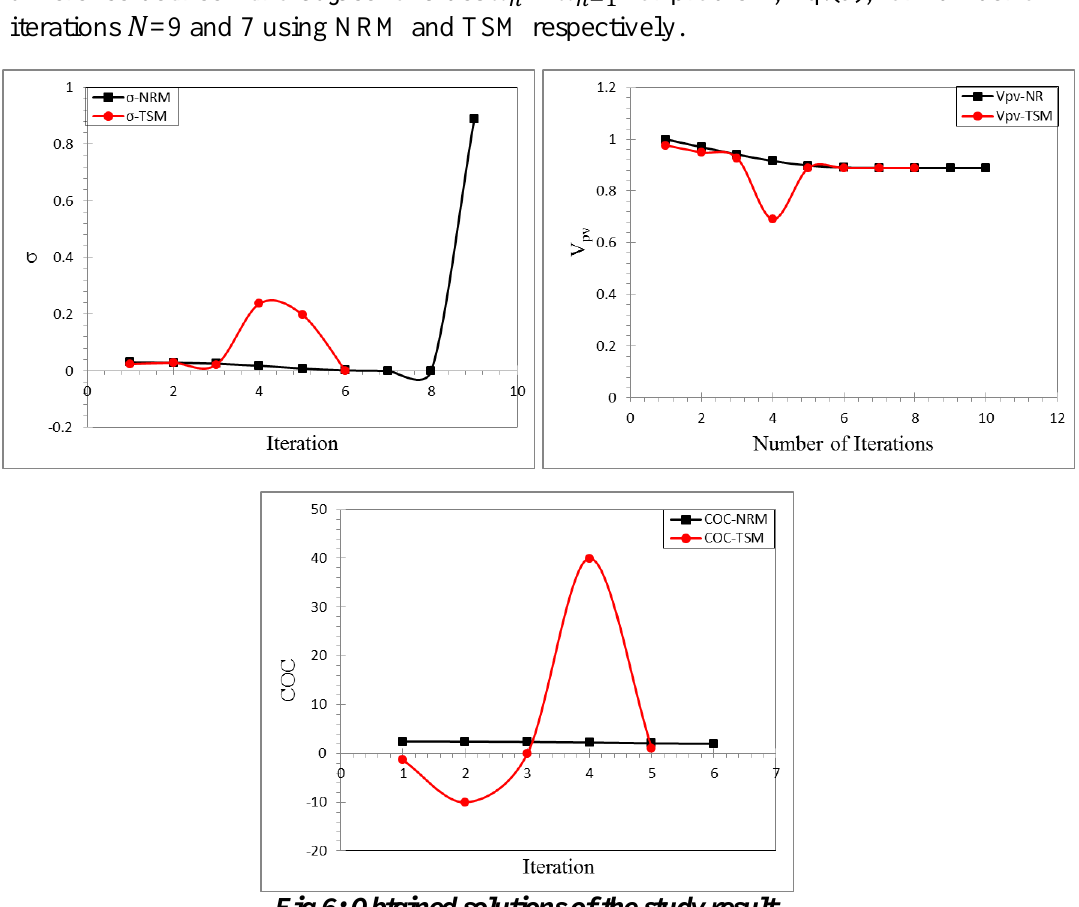
Fig.6: Obtained solutions of the study